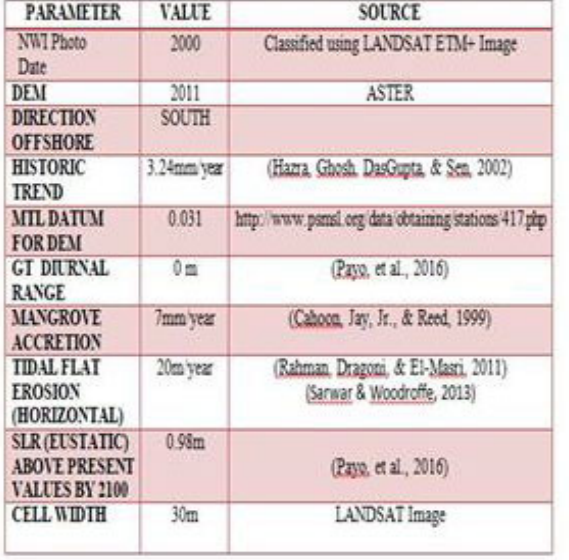
Figure 5: Google earth image of the year 2001 and 2016 demarcating estuarine beach and sand deposit (area drawn in red polygon) depicting real world GREAT DIURNAL TIDAL RANGE